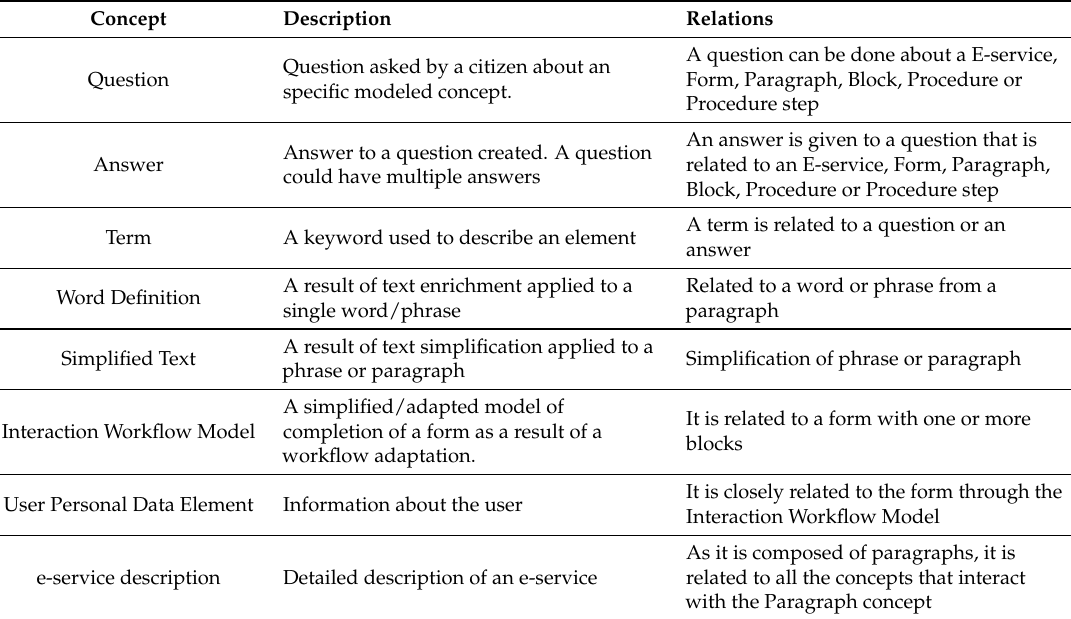
Figure 3. Procedure-Interaction Model. Table 1. Modeled concepts, descriptions and